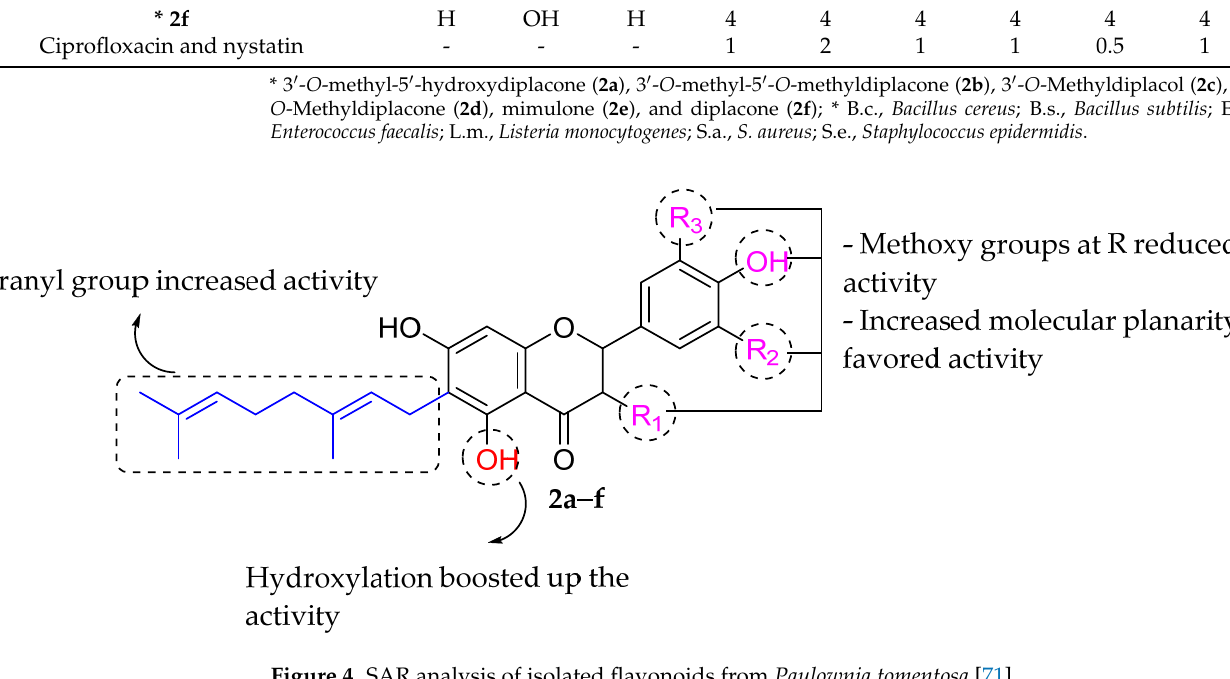
Figure 4. SAR analysis of isolated flavonoids from Paulownia tomentosa [71].